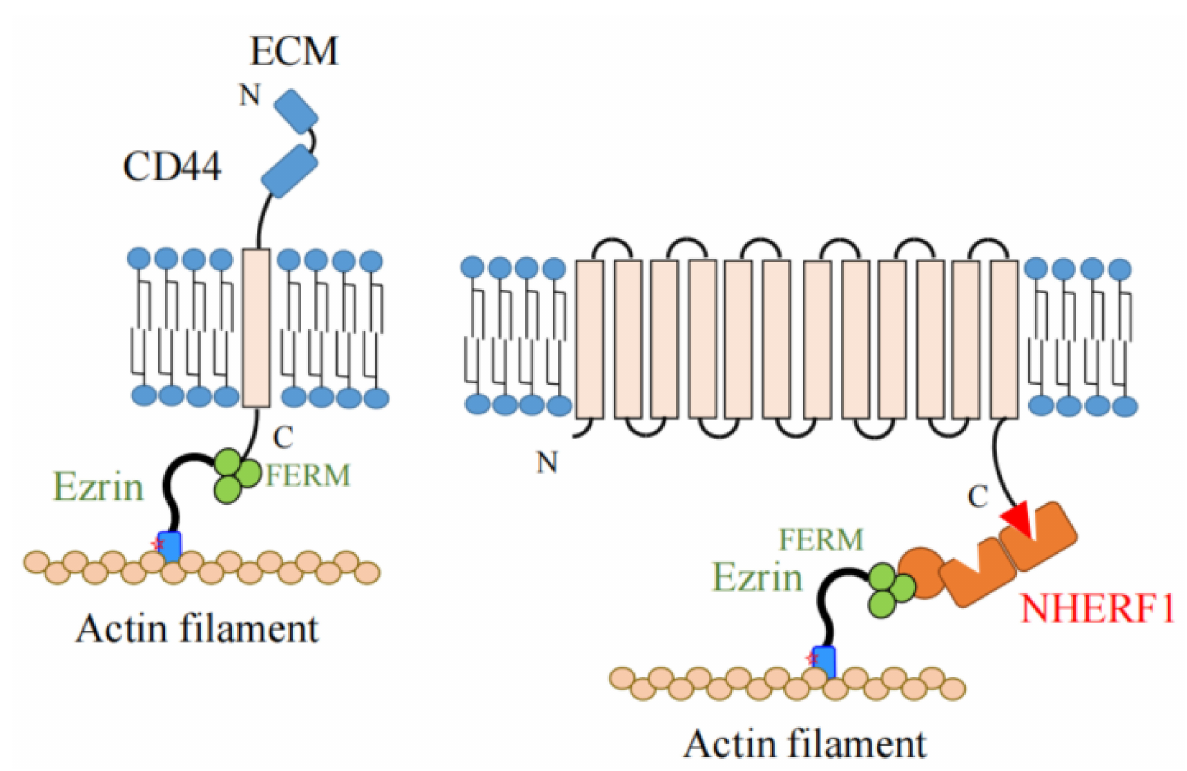
Figure 3. Ezrin functions as a cross-linker between membrane proteins and actin filaments directly or indirectly via scaffold proteins. ( Left ) Ezrin directly cross-links cell adhesion molecules such as CD44 and actin filaments. In this case, ezrin plays a key role in intermolecular communication between adhesion proteins attached to the extracellular matrix (ECM) and the actin cytoskeleton. ( Right ) Ezrin cross-links ion channels (such as CFTR), transporters (such as NHE3, Npt2a), and receptors (such as β 2 AR) to actin filaments indirectly via scaffold proteins such as NHERF1 (shown by orange boxes and circle). In this case, ezrin binds to the ERM binding site (shown by an orange circle) of scaffold proteins via the FERM domain (shown by clover-shaped green